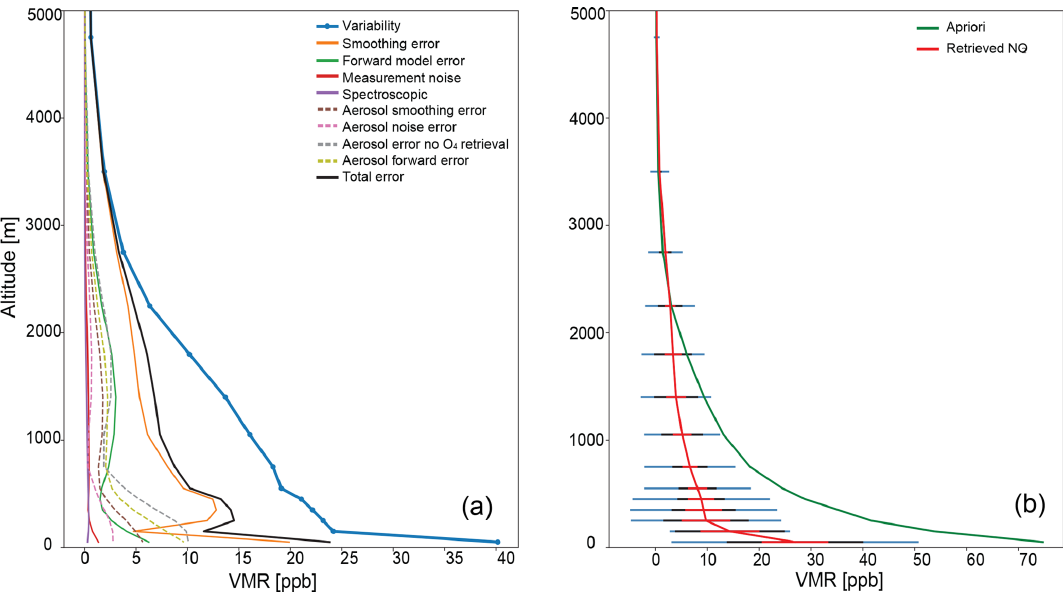
Figure 6. Altitude-dependent errors in a NO 2 VMR profile measured at 13:58 on 20 May 2016 (UTC − 6). (a) The square root of the diagonal in the covariance matrix describing the individual error contributions in the VMR profile and (b) the retrieved NO 2 VMR profile with corresponding error bars (total error and variability). Panel (a) also includes the a priori profile in green.